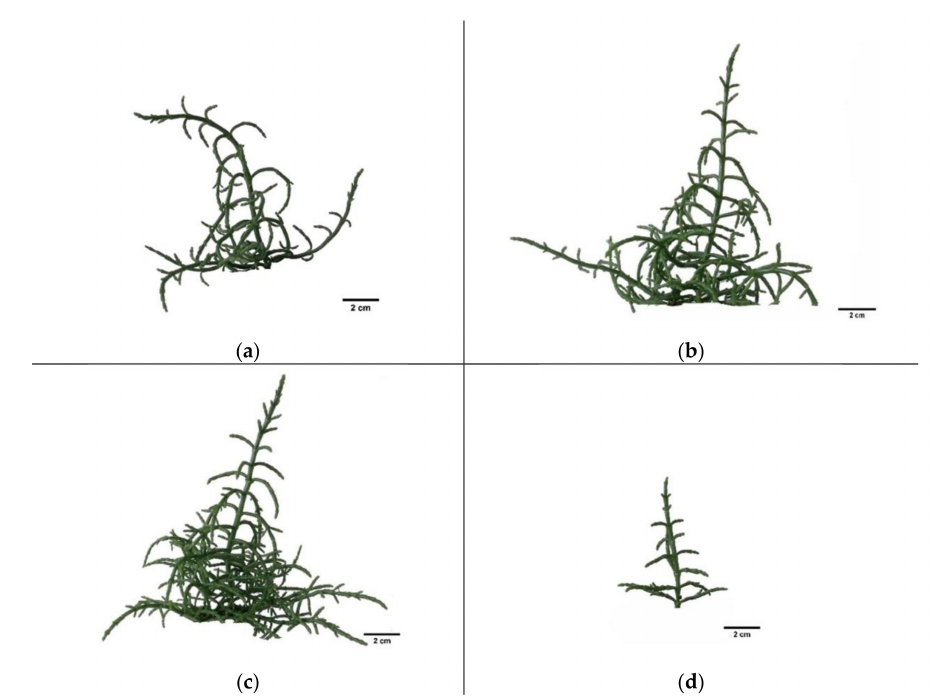
Figure 1. Images of Salicornia europaea L. grown in different NaCl concentrations: ( a ) 0 mM;